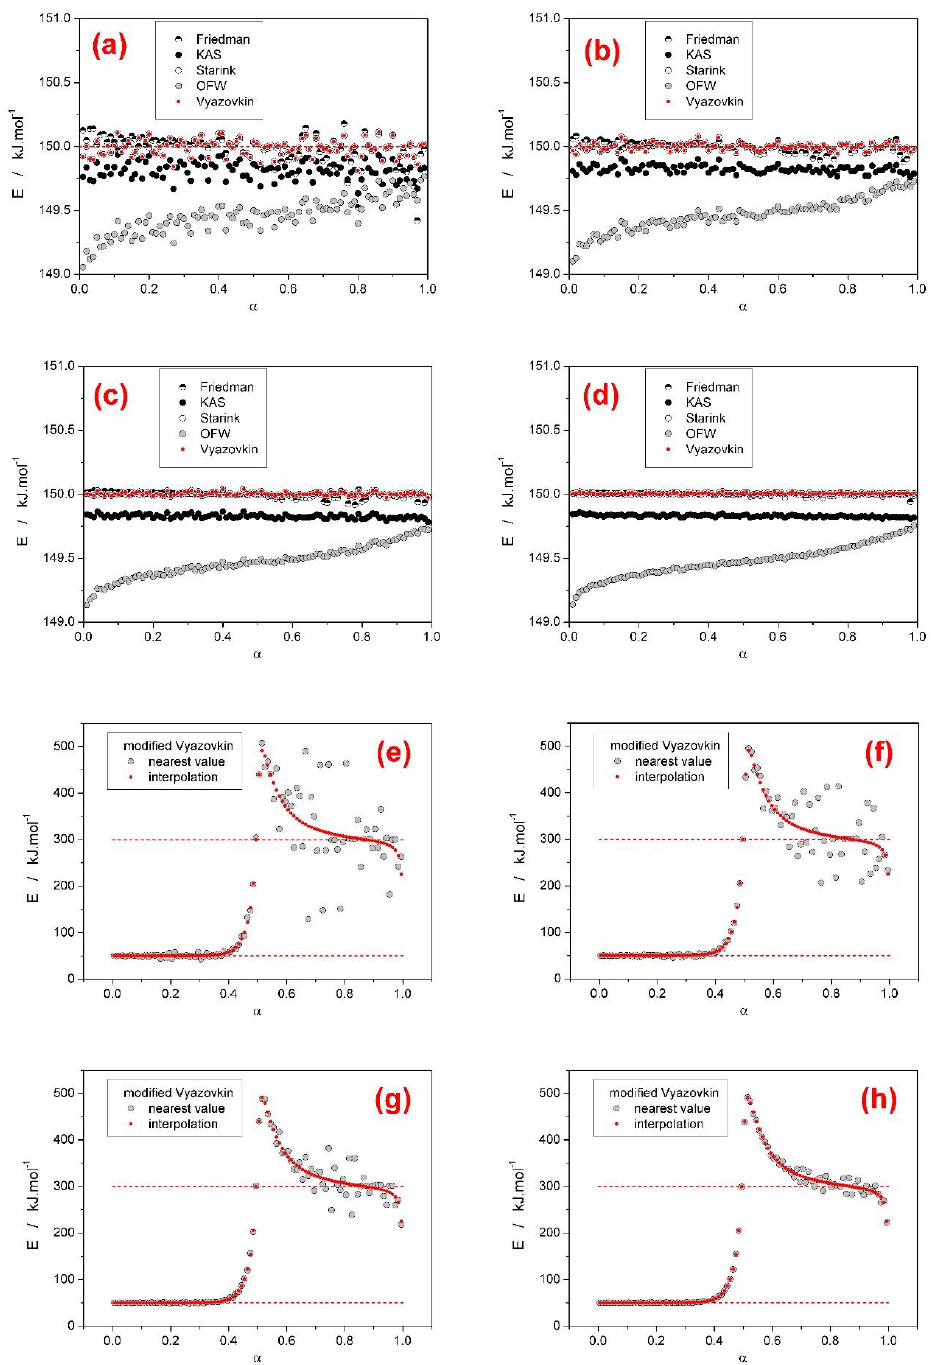
Figure 5. Upper four graphs: Results of the Friedman, KAS, Starink, OFW and Vyazovkin analyses applied to the dataset F (group 1). Each graph represents evaluation made from the dataset simulated with di ff erent (5000, 10,000, 20,000, and 50,000) points / curve density. The horizontal red dashed line in each graph represents the true E value input into the simulations. ( a ) set F, 5 k; ( b ) set F, 10 k; ( c ) set F, 20 k; ( d ) set F, 50 k. Bottom four graphs: results of the modified Vyazovkin method applied to the dataset B (group 2) and the I 1 = I 2 = 0.50 simulated at 5000, 10,000, 20,000 and 50,000 points / curve density. Data for the evaluations based on the nearest t / T values attribution versus proper interpolation are shown. From the 10,000 points / curve option, the trends are already clearly visible and quantifiable; as the number of points per curve increases, the smoothness of the E- α dependences rises and at 50,000 points / curve all the trends are unambiguous. ( e ) resolution 5 k; ( f ) resolution 10 k; ( g ) resolution 20 k; ( h ) resolution 50